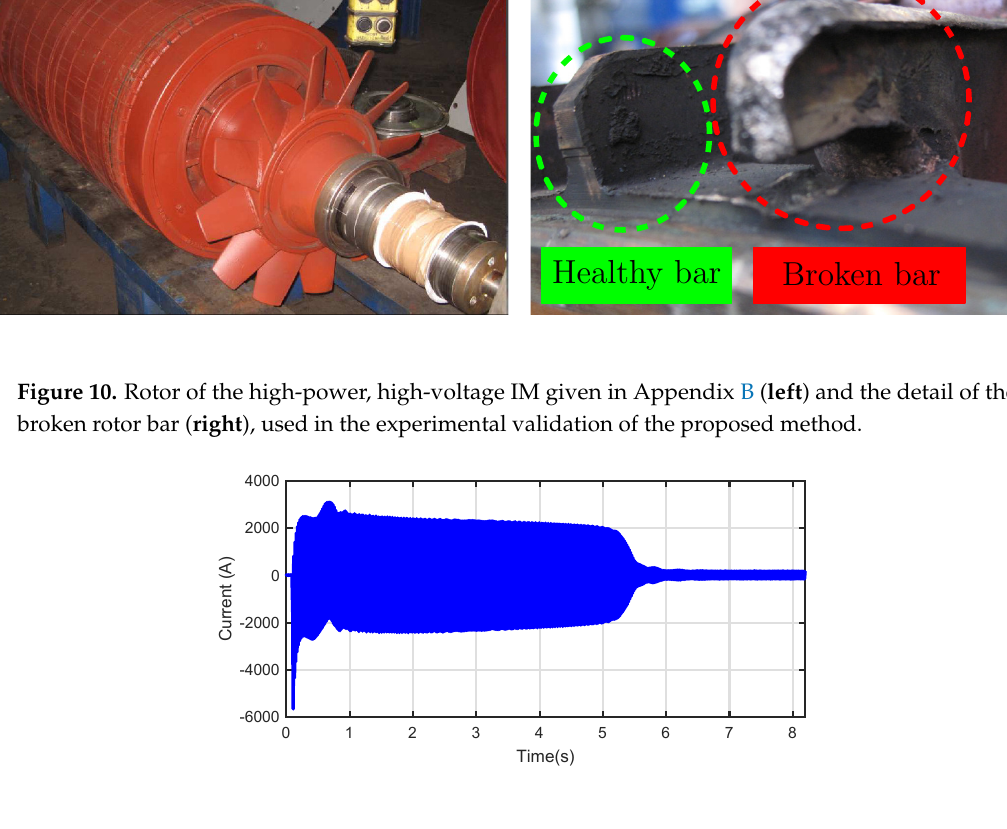
Figure 11. Stator current during the start-up transient of the high-power, high-voltage IM given in Appendix B with a broken bar